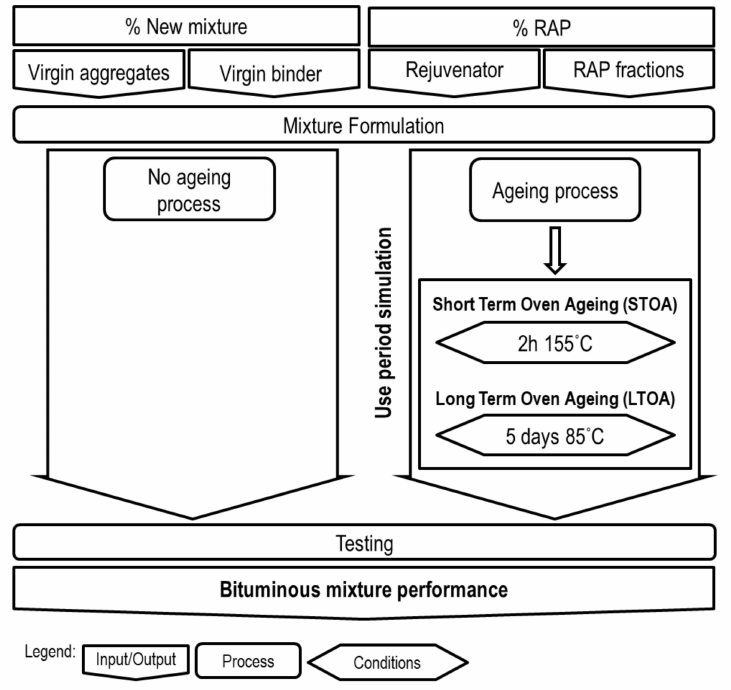
Figure 1. Bituminous mixture testing